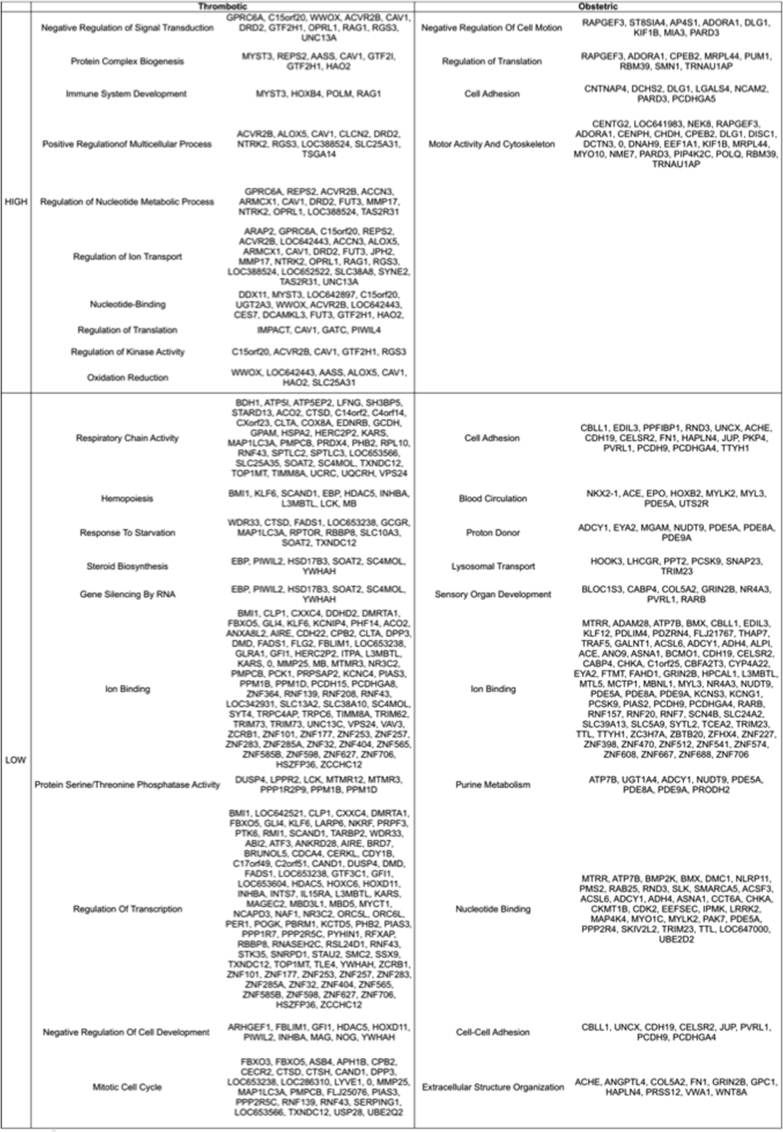
List of the DV genes included in the functional categories for VT-/PM+ and VT+/PM- IgG.